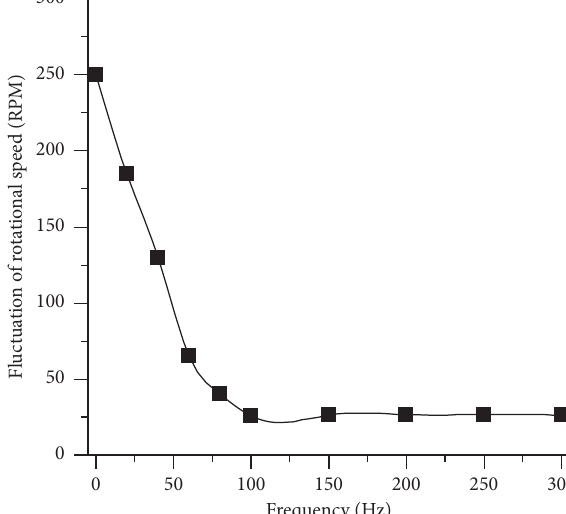
Figure 8: Influence of impact frequency on torsional stability of